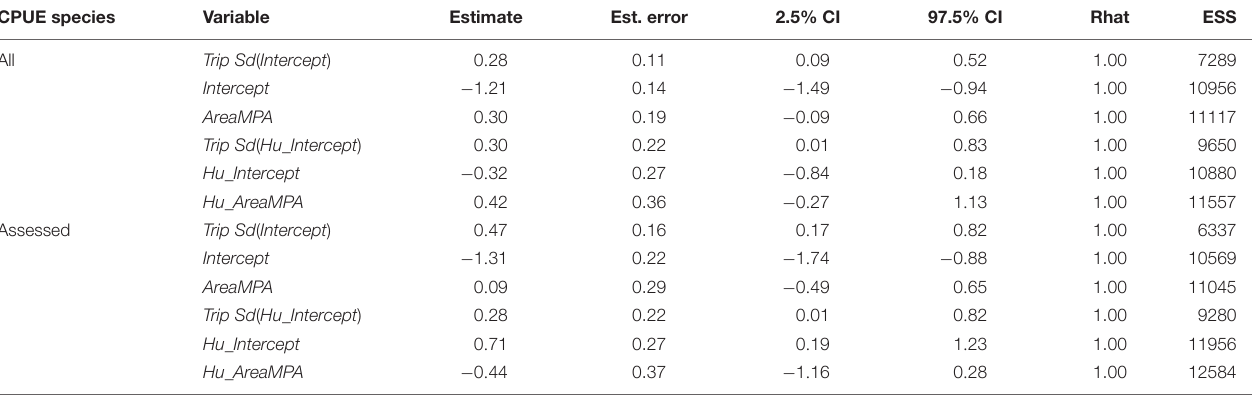
TABLE 6 | Results from the Area + Trip hurdle model for predicting reef fish CPUE. CPUE species Variable